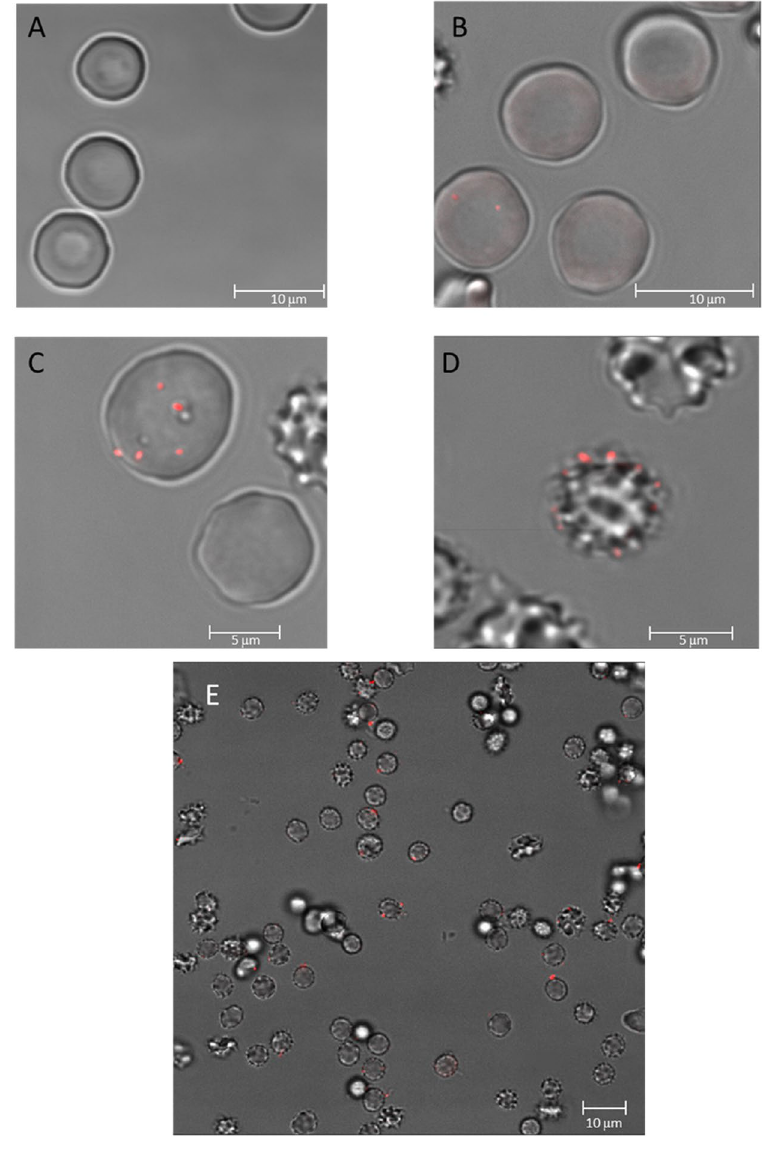
Figure 8. Confocal microscopy monitorization of ceramide generation over time during Pb 2 + incubation. Exposure times: 0 min ( A ), 8 min ( B ), 10 min ( C ), 20 min ( D , E ). Images are a combination of transmitted light and fluorescence confocal microscopy, where red dots indicate ceramide-enriched zones detected by the antiCer- antibody (Alexa Fluor 633 as secondary